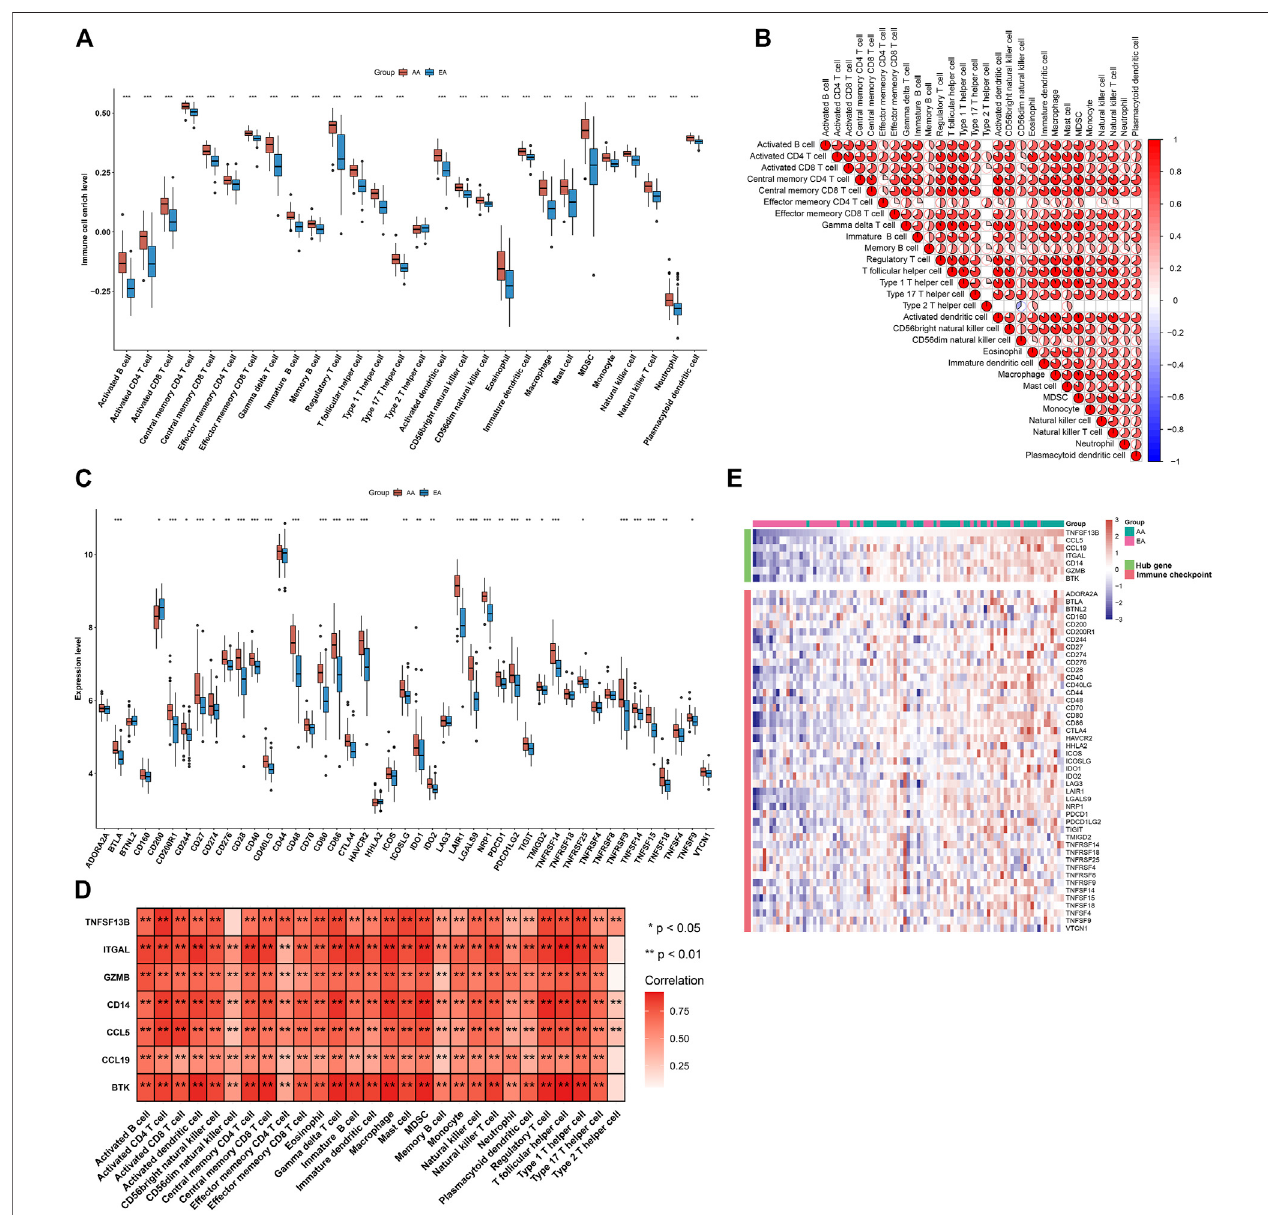
FIGURE 5 | Alterations in the immunological features from early-stage to advanced-stage atherosclerotic plaques and correlations between the characteristic genes and immunological features in the combined GSE28829 and GSE43292 datasets. (A) Box plots depicting the in fi ltration levels of immune cells in early-stage and advanced-stage atherosclerotic plaques. (B) Heatmaps depicting the correlations between distinct immune cell compositions. (C) Box plots showing the mRNA expression of immune checkpoints in early-stage and advanced-stage atherosclerotic plaques. (D) Correlation analysis of immune cell in fi ltrations with characteristic genes. (E) Visualization of the relationships between immune checkpoints and characteristic genes. * p < 0.05; ** p < 0.01; and *** p < 0.001.